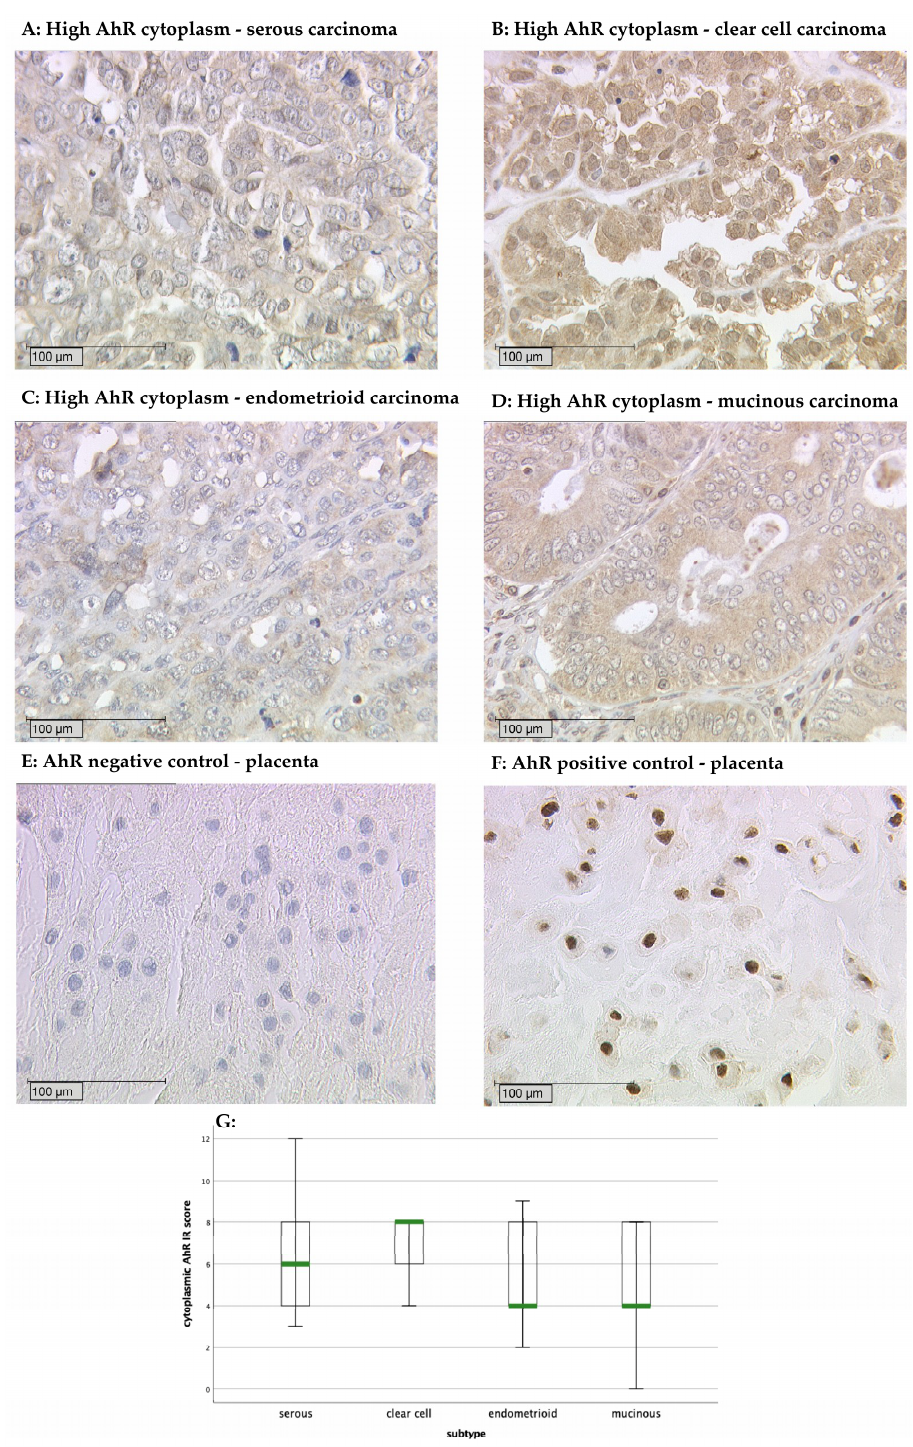
Figure 1. ( A ) High aryl hydrocarbon receptor (AhR) cytoplasm staining (immunoreactive score (IRS) > 3) in ovarian cancer with serous, ( B ) clear cell, ( C ) endometrioid, and ( D ) mucinous histology. ( E ) AhR negative control and ( F ) positive control in human placenta tissue. ( G ) AhR expression in the histological subtypes. The cytoplasmic AhR IR scores were compared between the different histological subtypes. The clear cell cancer specimens tended to have higher IR scores (median = 8) than the other carcinoma types ( p = 0.077).